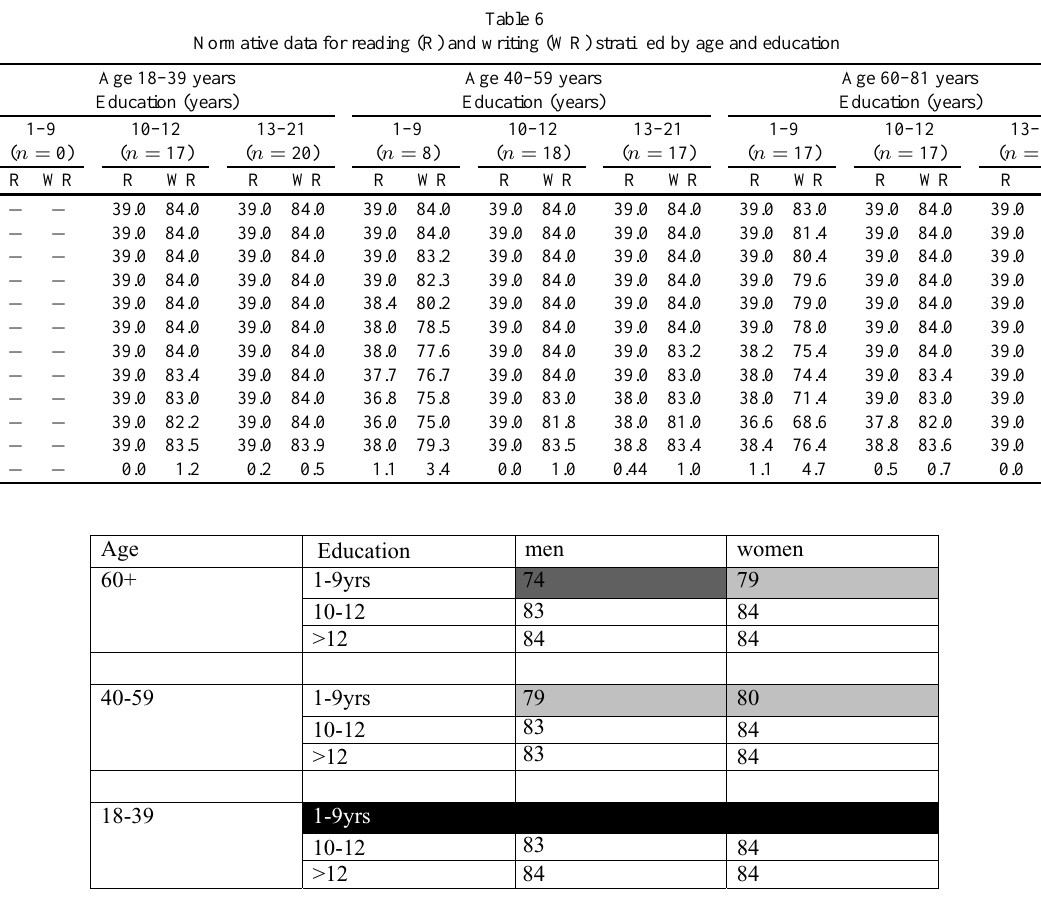
Fig. 2. Interaction between age and education and sex and education in the writing subtest. Cells of common shade have average scores that are not statistically significantly different from each other. The averages (standard errors) for different shades are: 83.9 (15.3) for clear shade; 79.0 (17.1) for light grey; 74.4 (22.8) for dark grey; and black cells are